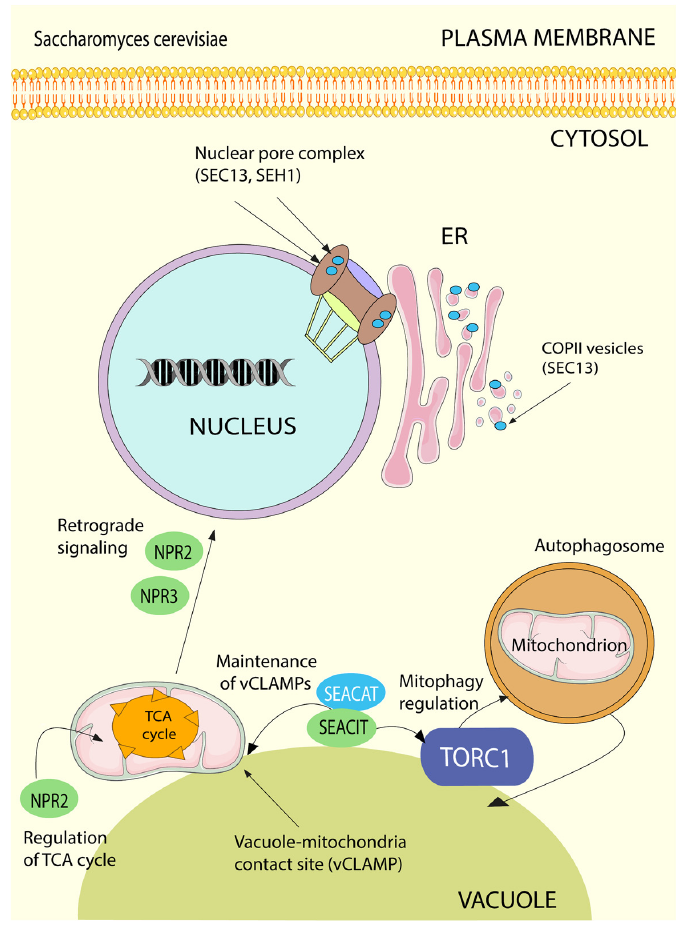
Figure 4. Functions of the S. cerevisiae SEA complex and its components beyond nutrient response. Indicated are Seh1 and Sec13 as components of the nuclear pore complex and Sec13 as part of COPII vesicles. Npr2 and Npr3 regulate retrograde signaling. Npr2 is also involved in the regulation of TCA cycle. Finally, SEA complex is involved in the maintenance of the vacuole-mitochondria contact sites (vCLAMPs) and is important for mitophagy.